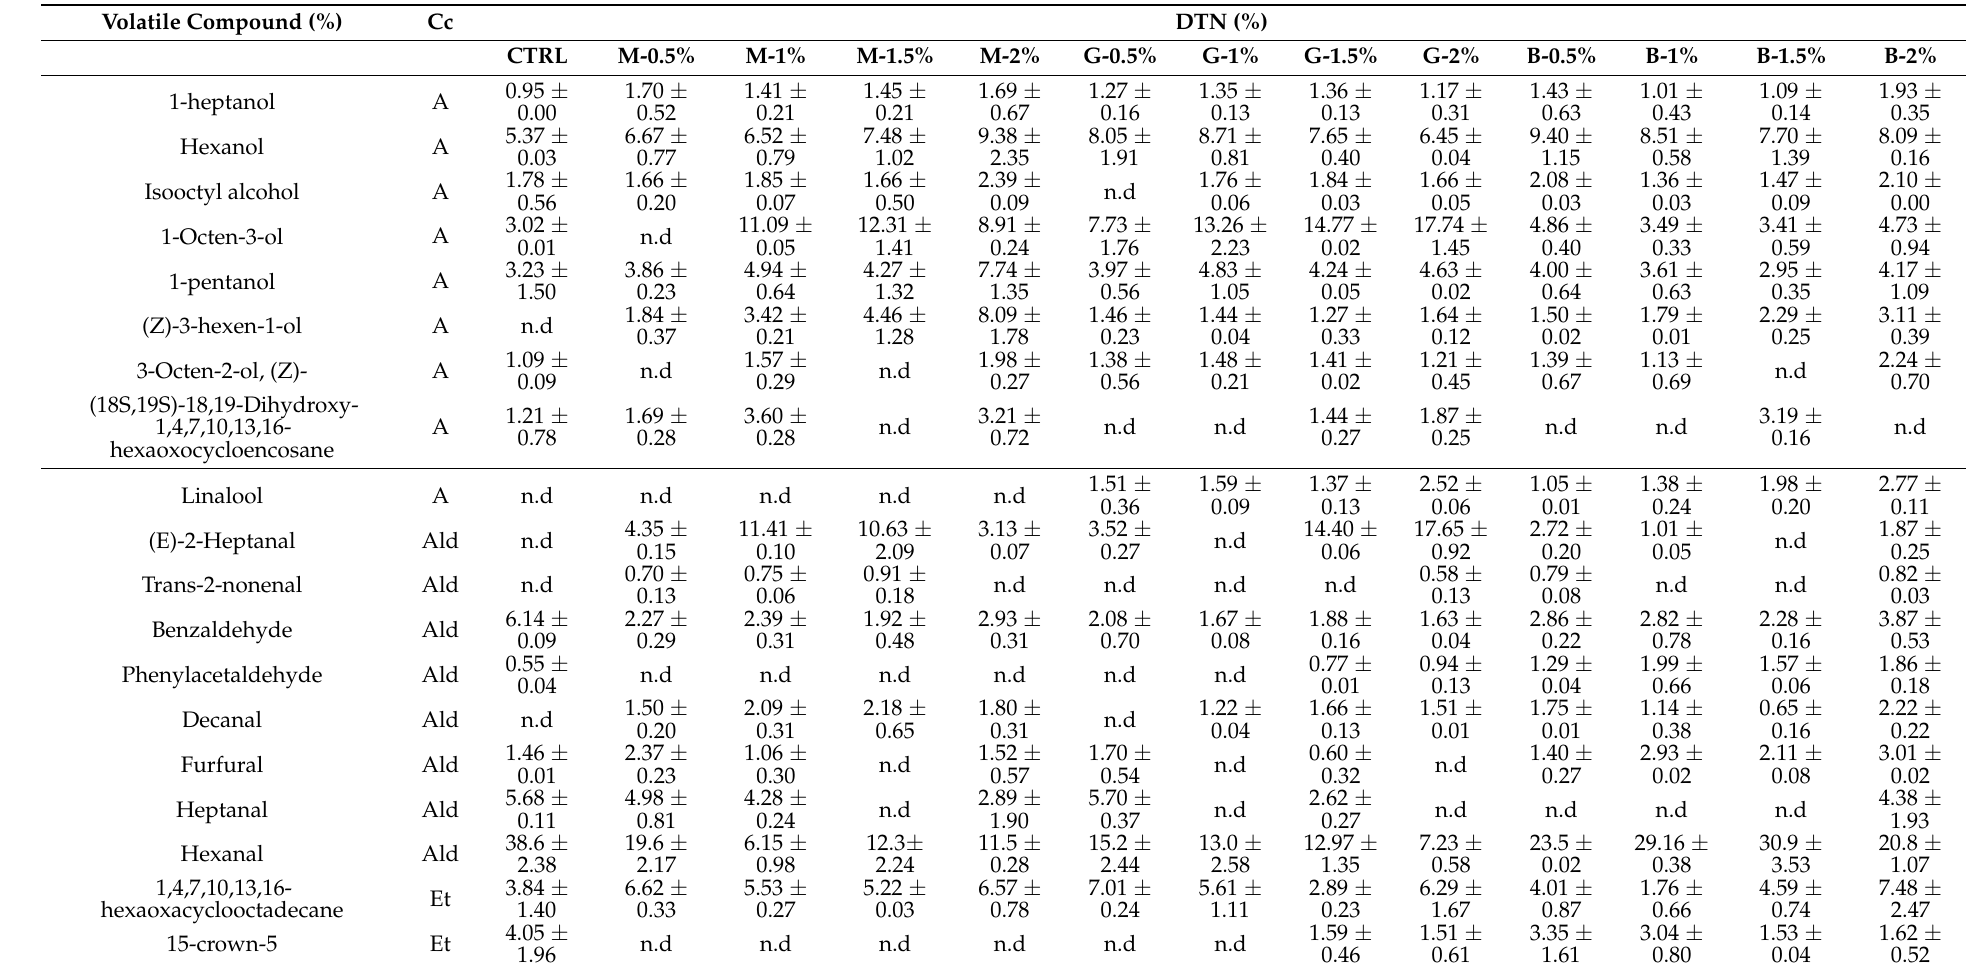
Table 5. Gas Chromatography-Mass Spectrometry (GC-MS) analysis results of volatile compounds in DTN